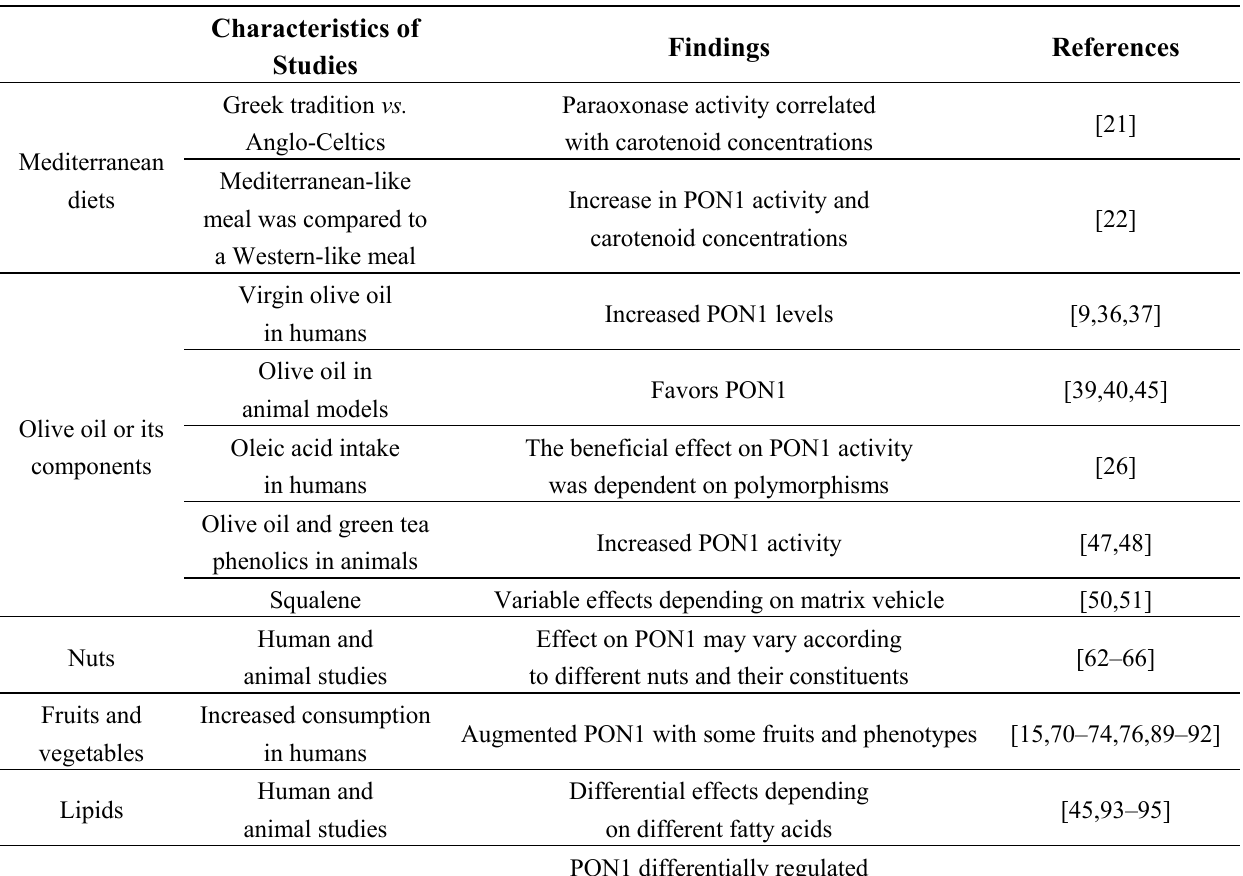
Table 2. Overview of the studies